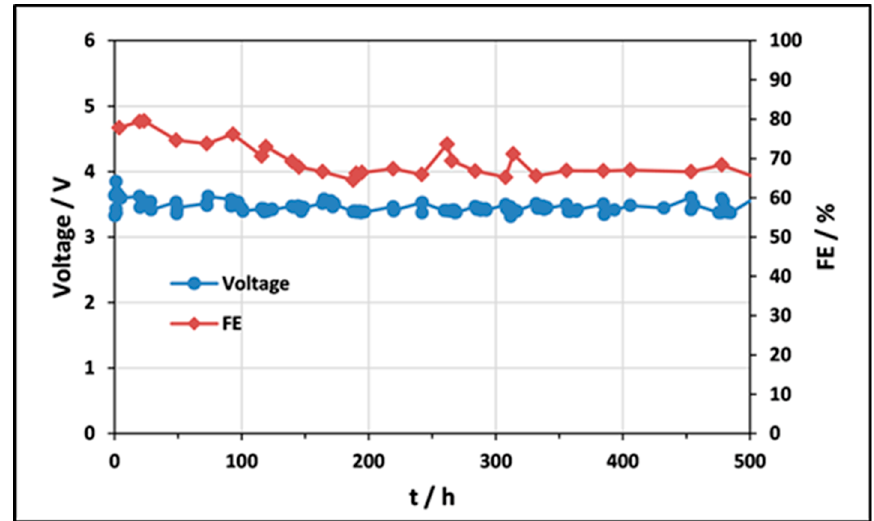
Figure 6. The performance of a 5 cm 2 formic acid test cell, producing 10 wt% formic acid operating at 200 mA/cm 2 , with a candidate cathode electrocatalyst.